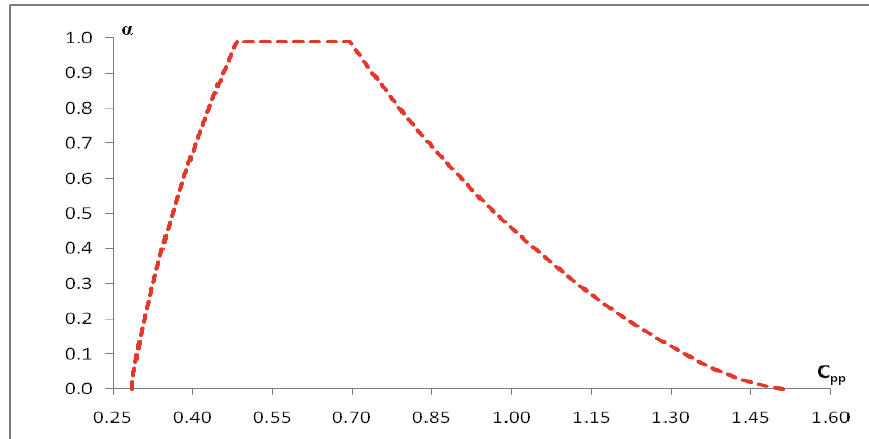
C for Supplier-C pp